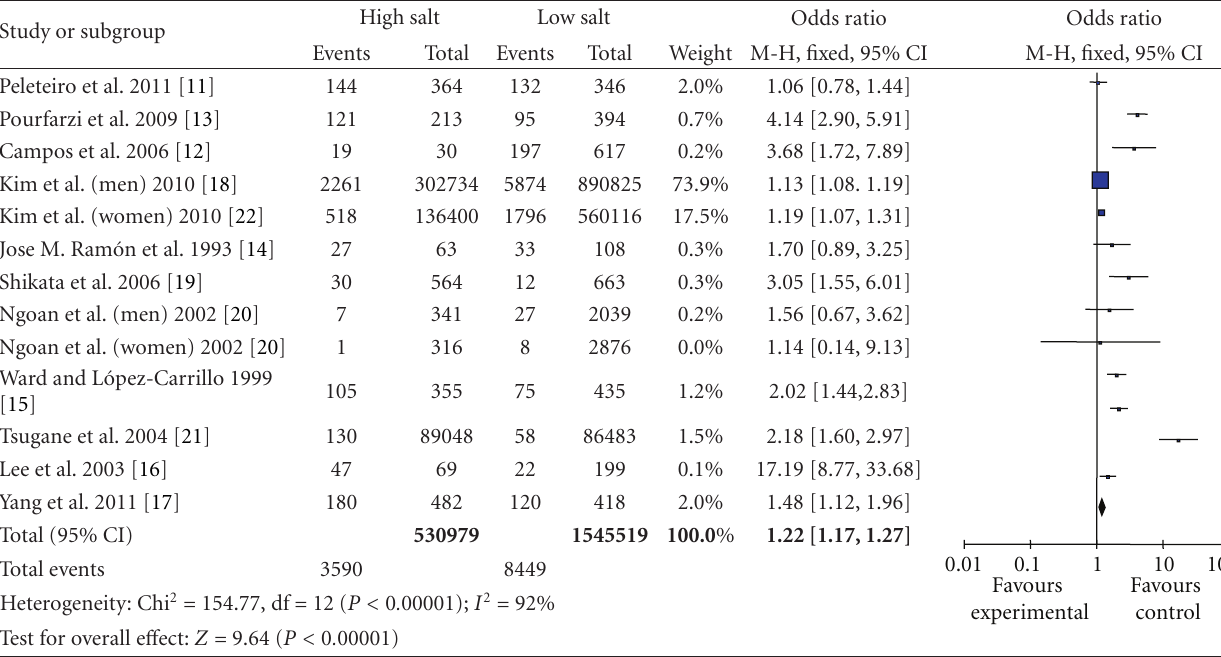
Table 3: High versus low categories of salt and gastric cancer.